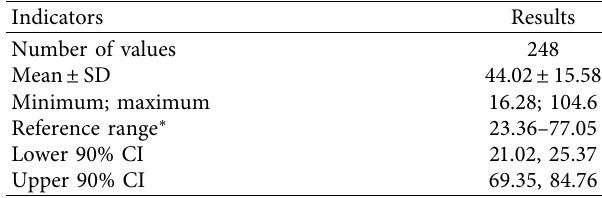
Figure 3: Normal distribution analysis of P1NP results of male. (a) Normal QQ plot analysis. Each point means the deviation from the diagonal (red line). The more the data fall on the diagonal means the more the possibility to meet the normal distribution. (b) Frequency distribution analysis. 248 data were divided into groups; the column volume means the total number of this group. Table 1: Summary table of frequency